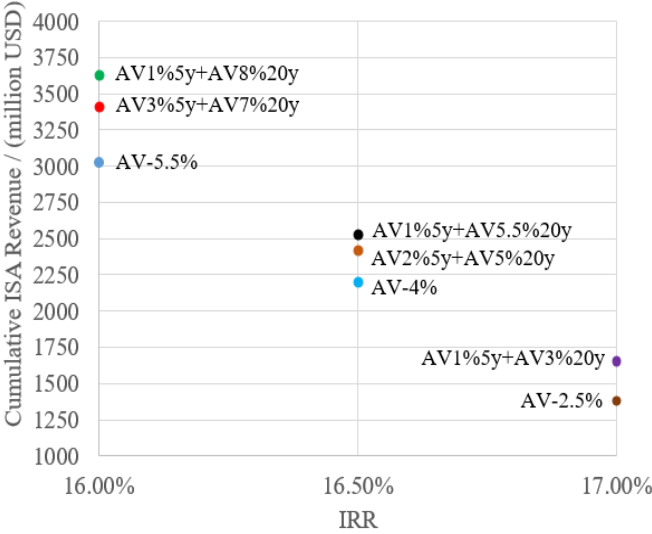
Figure 10. IRR and cumulative ISA revenue with different payment systems.